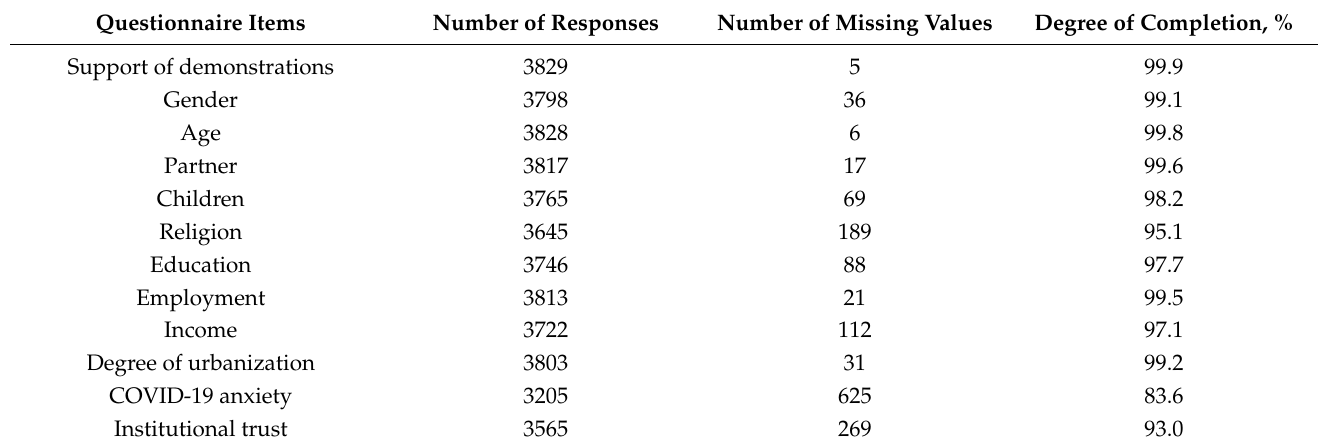
Table A1. Degree of completion of questionnaire items. Gross sample: n =